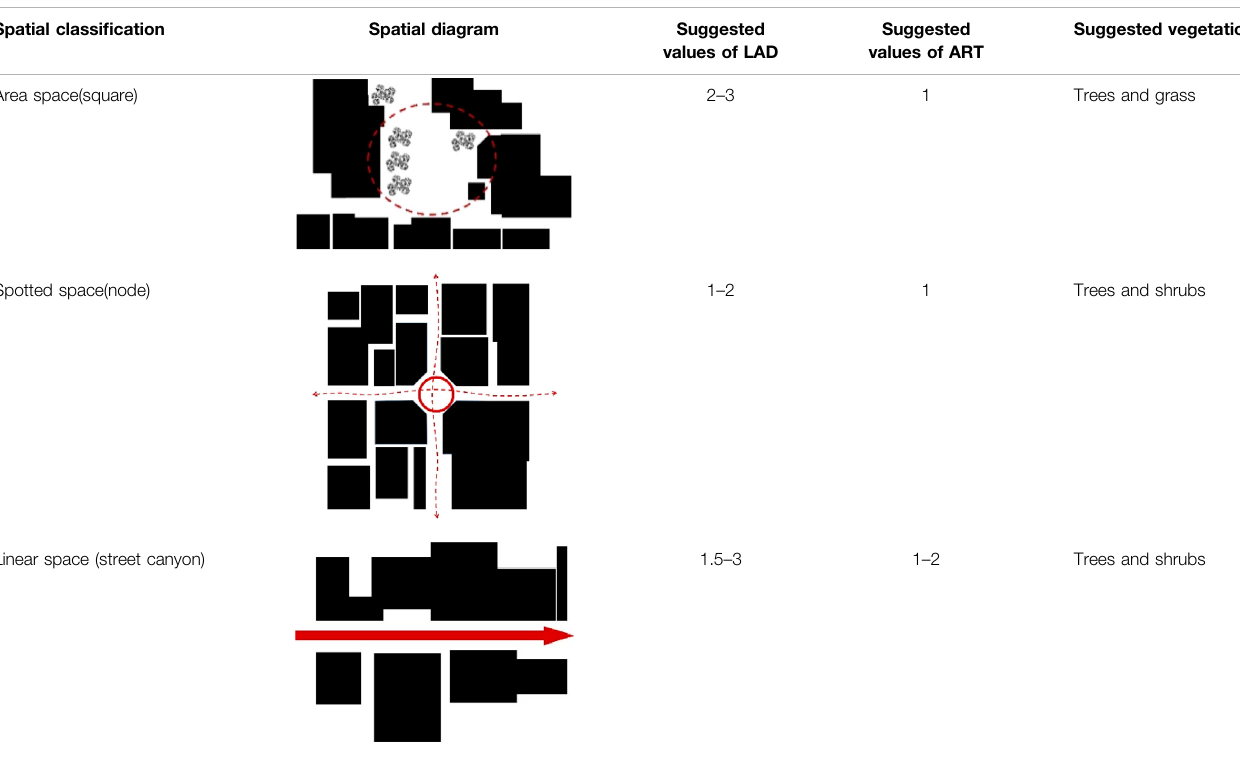
TABLE 10 | Design implications of